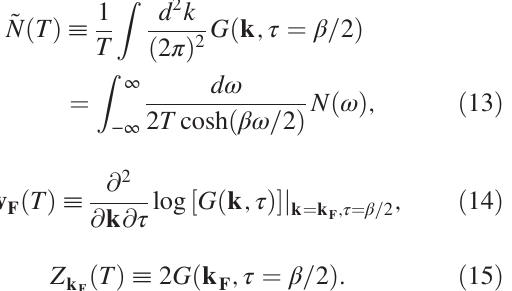
FIG. 16. (a),(b) Pairing susceptibility in the s -wave and d -wave channels, P [Eq. (11)], as a function of h , at T ¼ 0 . 083 . s;d Different system sizes are displayed. (c),(d) P temperature at the QCP, h ¼ 3 .